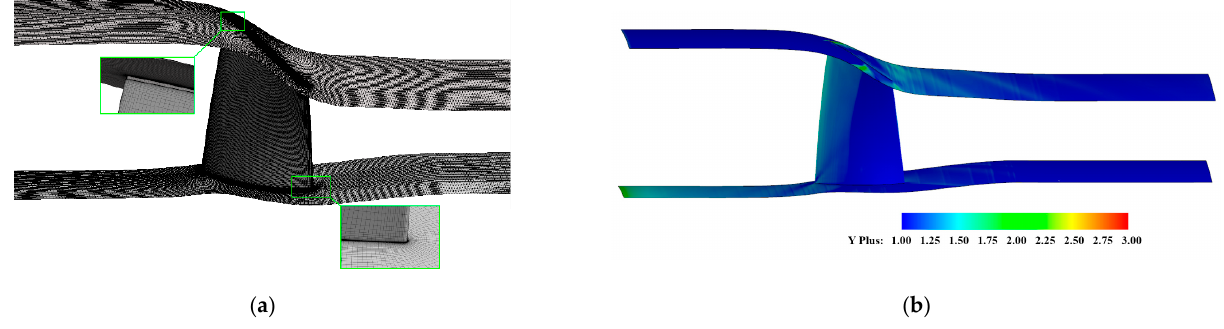
Figure 2. Mesh generation and wall y plus. ( a ) Grid generation. ( b ) Grid wall y plus at design load.